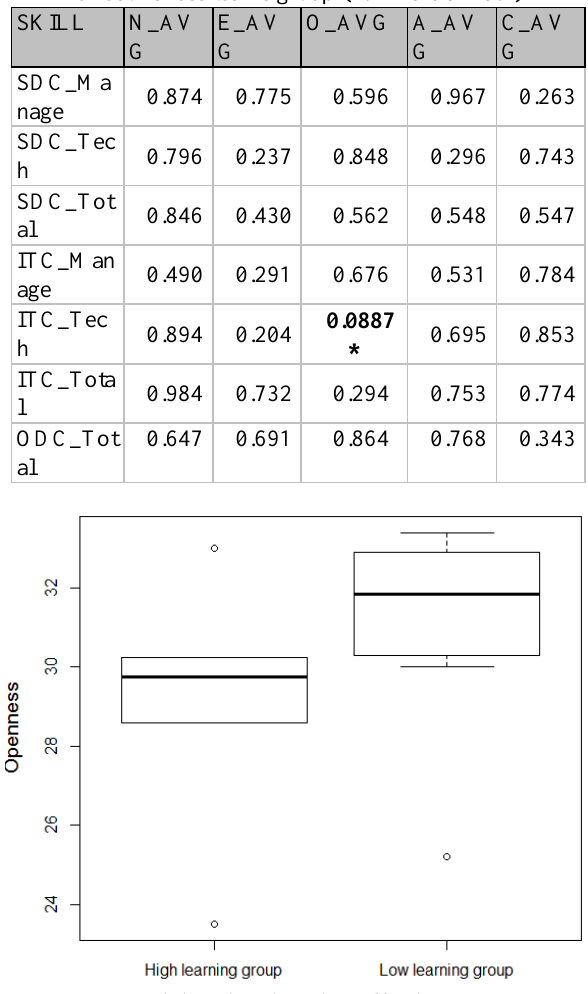
Figure 10. High or low learning effectiveness team’s average value of Openness in the IT management course (2) Variance value of